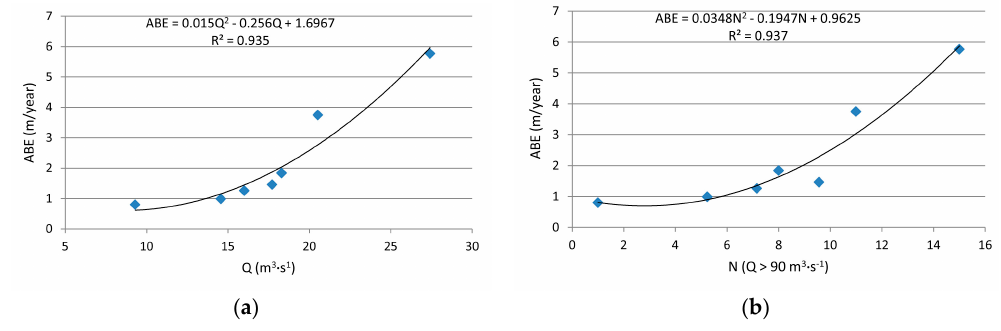
Figure 6. Estimation of average annual riverbank erosion ABE (m · year − 1 ) using the mean annual discharge (m 3 ·s − 1 ) ( a ) and the number of annual discharges which exceed the value of 90 m 3 ·s − 1 (N) ( b ). According to another dependence (Figure 6b), the riverbank will move up to one meter per year if a daily discharge of 90 m 3 ·s − 1 or more occurs no more than five times per year. With higher frequency, riverbanks become more erodible, and a case from 2014 showed that this threshold may exceed 15 times and thereby move the riverbank almost six meters. Comparing these two dependencies, one can conclude that the second might be more practical. The first reason is that the mean annual discharge only indirectly applies to frequent water, like bank-full discharge and that extrapolations are actualize very rare (only the 1970s and 2010 in the whole series). On the other hand, the number of overcoming bank-full discharge are data that directly affects the vulnerability of riverbanks. Although the maximum value observed in the series was 15 (2014), the number of occurrences over the threshold for 58 years is five.